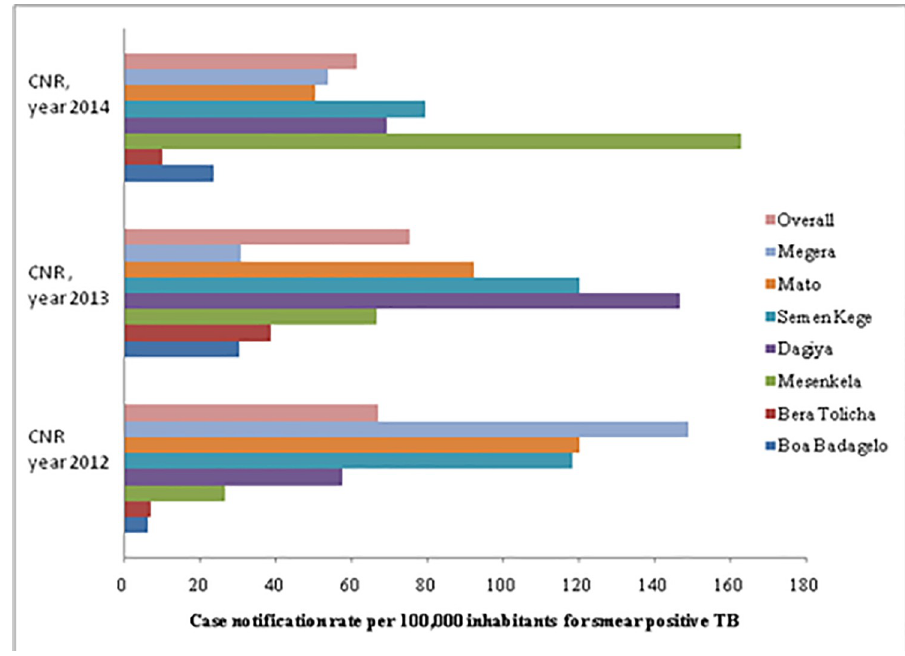
Fig 7. Notification rate for smear-positive TB over a period of time across the studied health facilities in Dale district, Sidama Zone, Southern Ethiopia.